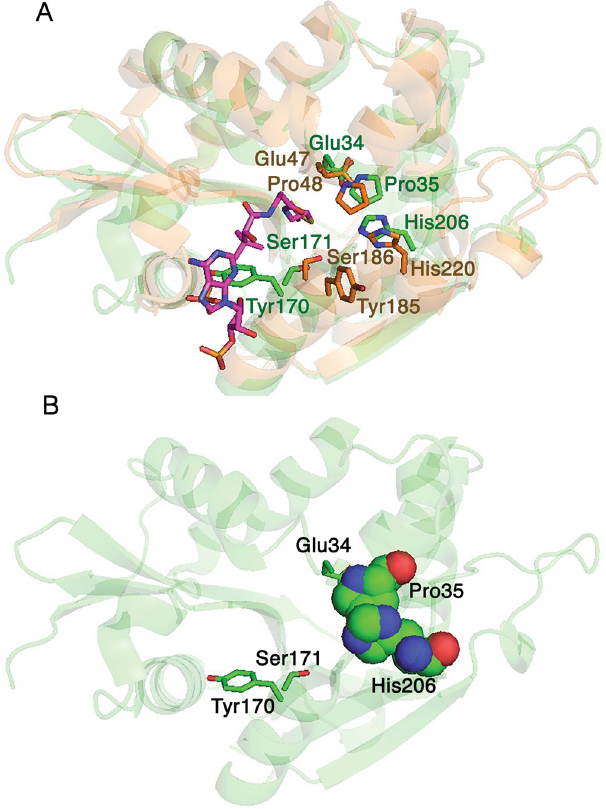
Figure 2. AgmNAT active site. ( A ) Superimposed structures of the apo AgmNAT (green, PDB 5K9N) and the dopamine N -acetyltransferase-acetyl-CoA complex (AANATA) structure (orange, PDB 3TE4) showing active site residues and acetyl-CoA (purple) from the AANATA (3TE4) structure. All relevant residues are shown in stick. The helix bearing Tyr-170 and the loop to its left form the binding site for the adenosine 3-phosphate 5-pyrophosphate portion of coenzyme ( A ). ( B ) Highlights the relative position of Glu-34, Pro-35, Tyr-170, Ser- 171, and His-206 in the active site. Additionally, the van der Waals interaction between Pro-35 and His-206 is shown.